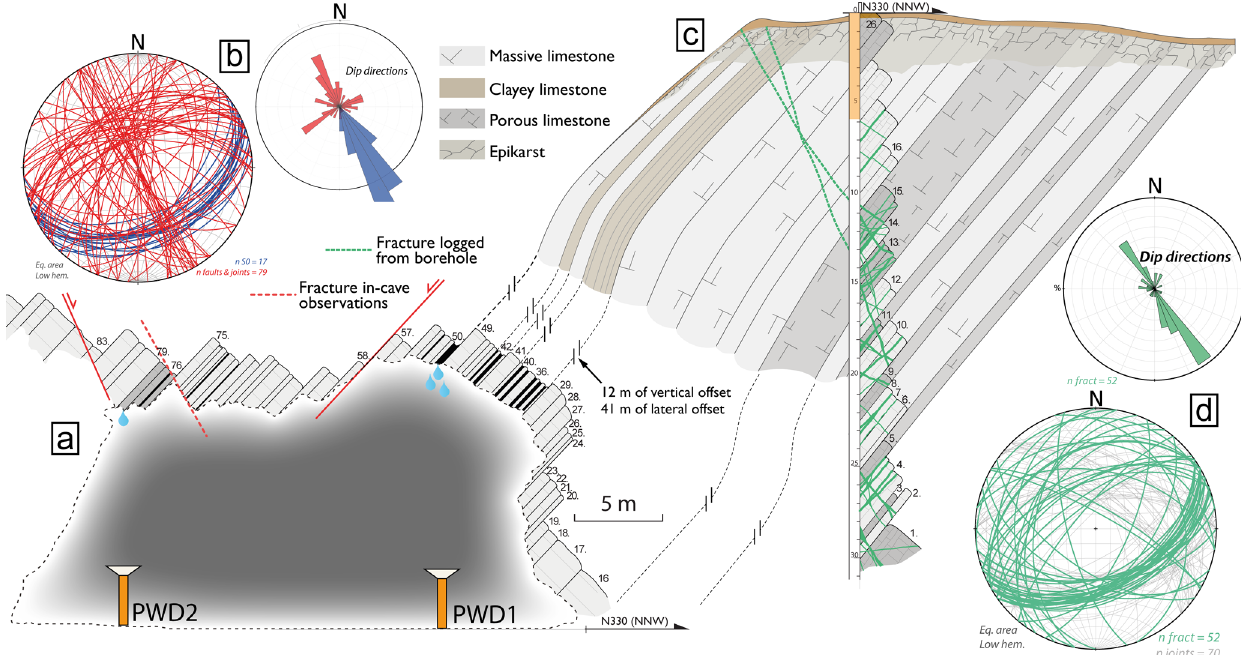
Figure 8. (a) Cross section of the Val d’Enfer room (location highlighted as a dashed line in Fig. 1c), clayey layers (black) and porous limestone layers (dark grey) are highlighted in the massive limestone pile (light grey). Fractures with evidence of displacement are noted in plain red. Two of the percolating water gauges are represented in the cross section (PWD1 and PWD2). PWD3 is located in a smaller passage 40m north-west of PWD1. (b) Stereogram (Schmidt lower hemisphere; left) and rose diagram (right) of the planes attributed to bedding planes (blue) and fractures (red), deduced from statistical analysis of a 3-D model of the Val d’Enfer room. (c) Cross section corresponding to the ERT profile (see location in Fig. 1) based on logging of core samples and image survey of the borehole. Main plans are highlighted in green (sedimentary discontinuities or parallel fractures). Dashed green represent the extrapolation of two main fractures towards the surface of the profile. (d) Stereogram (Schmidt lower hemisphere; bottom) and rose diagram (up) of the plans highlighted in green in 2c. Note that (a) and (c) are separated by vertical and lateral offsets of 12 and 41m